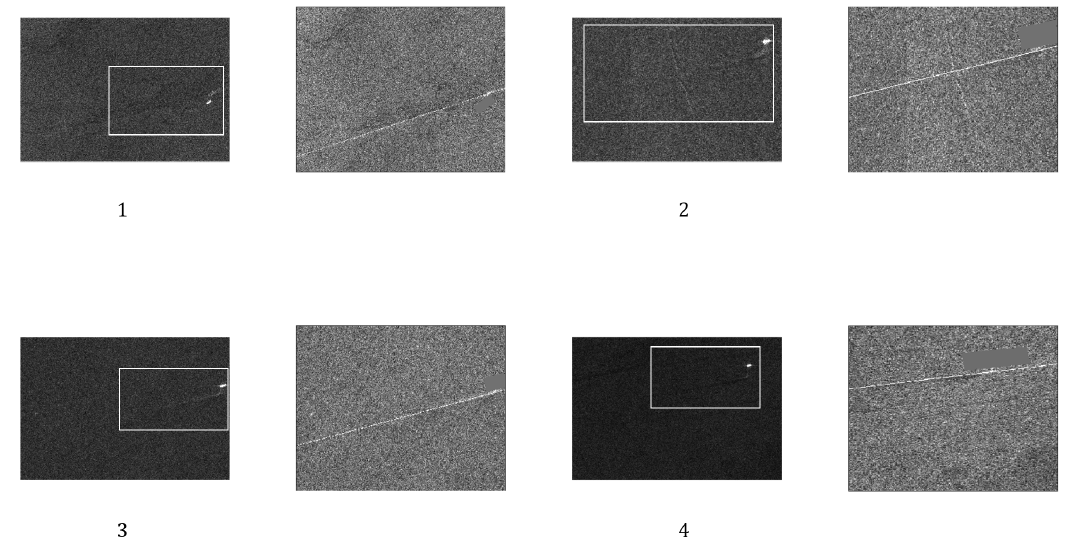
Figure 17. Results of the turbulent wake detector applied on the first four wakes from the dataset represented in Figure 16. Input images are identified by their ID number. Processing results of relevant areas (identified by white bounding rectangles in the input maps) are represented next to input images.